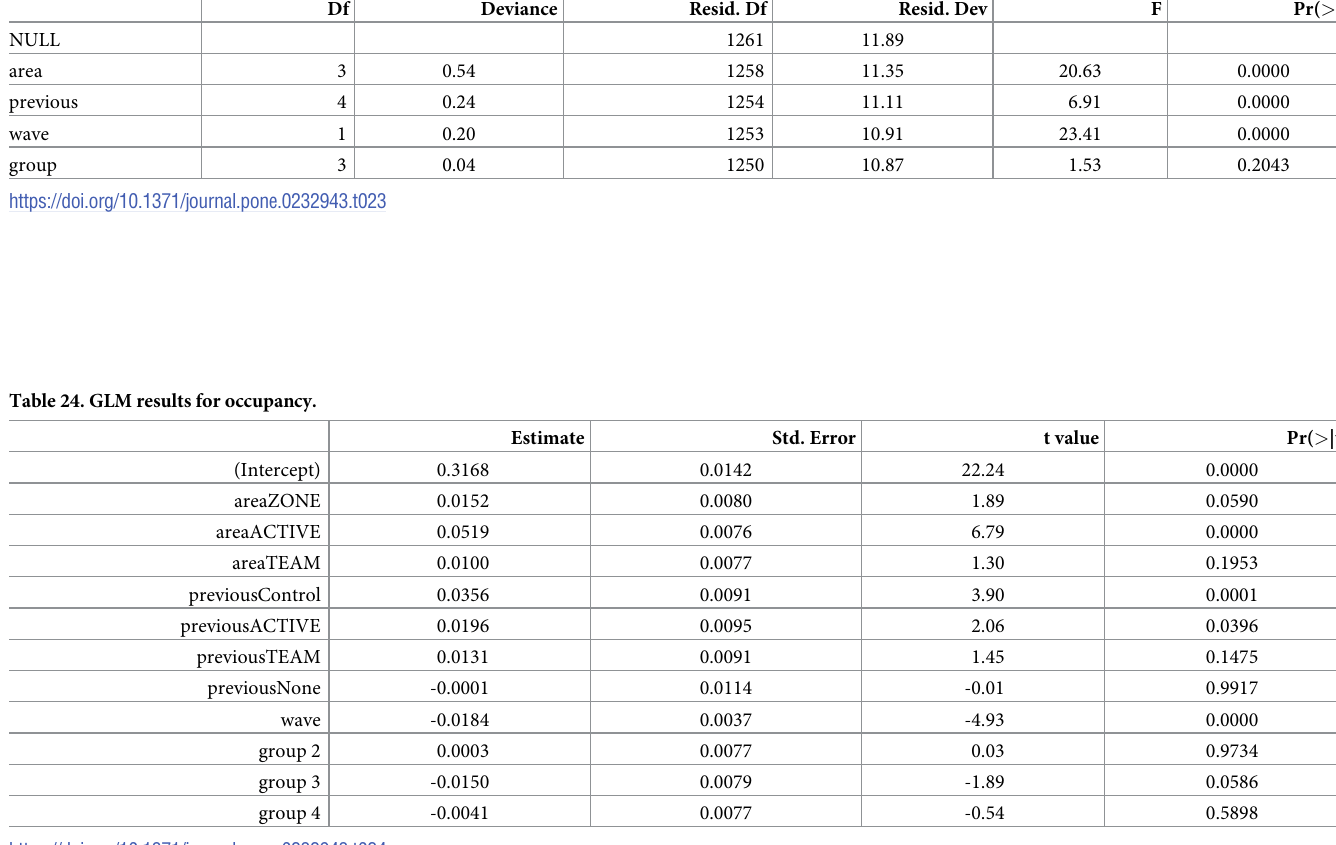
Table 23. ANOVA table for occupancy. Df Deviance Resid. Df Resid. Dev